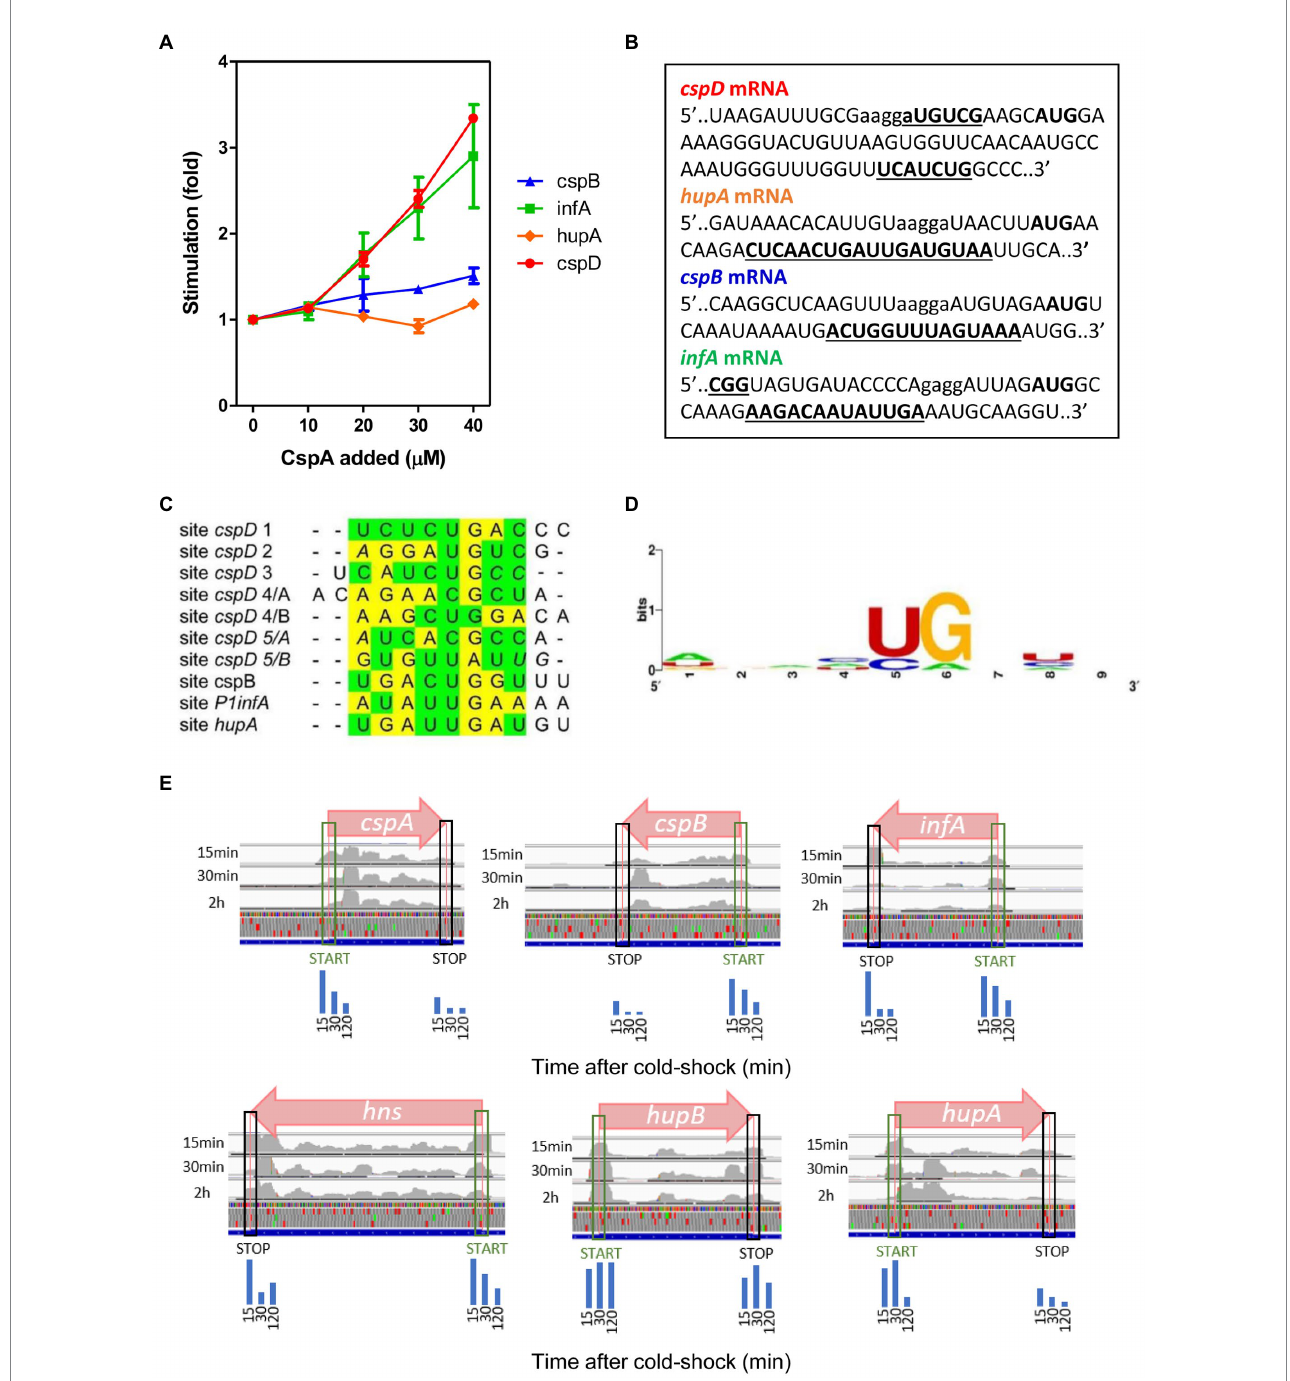
FIGURE 5 CspA binding to various mRNAs and functional effects. (A) In vitro translation at 15 ° C performed with control 70S and S100 in the presence of P1infA mRNA (green squares), cspD mRNA (red circles), cspB mRNA (blue triangles), hupA mRNA (orange diamonds) and the indicated amounts of purified CspA. The data points are the average of two independent experiments and the error bars represent the standard error. (B) CspA binding sites (bold underlined) identified around the Translation Initiation Region (TIR) of the indicated mRNAs by crosslinking experiments performed at 15 ° C. SD sequence and start codon are indicated in lower case and bold, respectively. (C) Manual multiple alignment of the sites cross-linked/ footprinted by CspA on the indicated mRNAs. Since CspB, the CspA-homolog of Bacillus subtilis , recognizes a sequence of 6–7 nts (Lopez and Makhatadze, 2000; Sachs et al., 2012), we hypothesized that the sites in which the cross-links/footprints were particularly extended (> 12 nts) could be the results of the binding of two adjacent CspA molecules. For this reason, we divided these extended sites into two sub-sequences of comparable length, named A and B, which were used to build the alignment. The yellow and green highlighting indicates purines and pyrimidine, respectively. The bases in italics are adjacent to those crosslinked by CspA. (D) Logo representation of the CspA binding preference derived from the alignment shown in panel C and generated with WebLogo (Crooks et al., 2004). (E) Coverage tracks of aligned reads from ribosome protected fragments derived from Zhang et al. (2018) visualized by IGV genome browser. Normalized ribosome densities are displayed at initiation and stop codons of different genes. Blue bars represent the quantization of peak densities at the start and stop codons at the three time points. From left to right, 15 min, 30 min, and 2 h, respectively. Normalized coverage tracks for cspA , cspB , infA , and hns mRNAs show peaks on start codons which progressively decrease during cold acclimation. Normalized coverage tracks for hupA and hupB mRNAs do not show the same trend and their initiation peaks remain relatively high even after several minutes of cold acclimation. CspD mRNA is not expressed under these